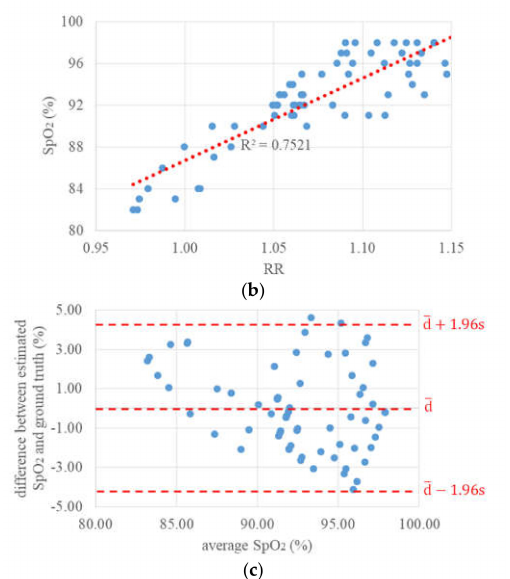
Figure 12. Continuous estimation of oxygen saturation: ( a ) Ground truth SpO 2 values and ratio of ratios (RR) values within 65 s, ( b ) linear regression between RR and SpO 2 values, ( c ) di ff erence between estimated SpO 2 and ground